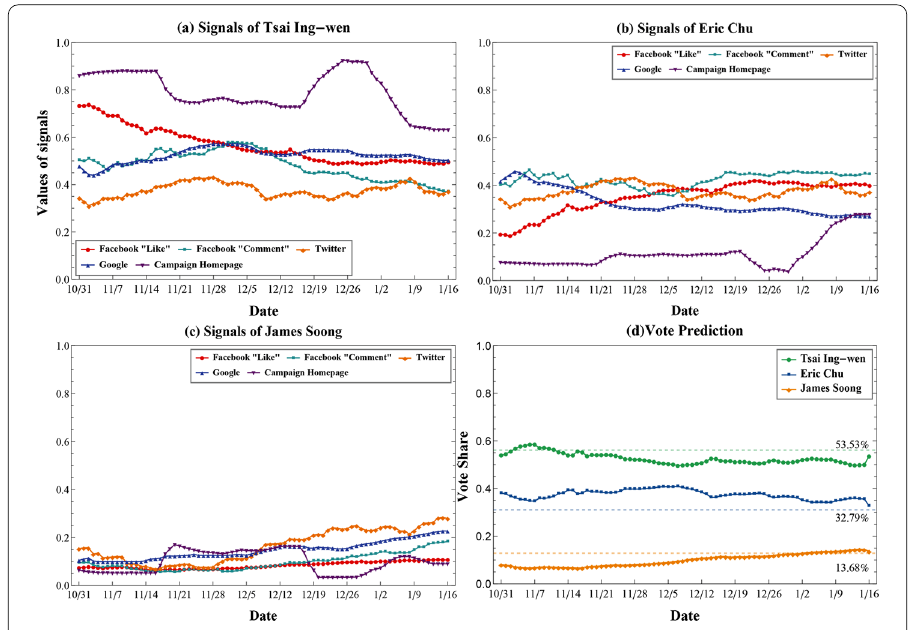
Figure 1 Online signals and time series of vote share predictions. ( a )–( c ) Signals of public opinions from all the online channels for the three candidates. ( d ) Time series of the vote share predictions. The dashed lines are the actual election outcomes. On election day, the errors are less than